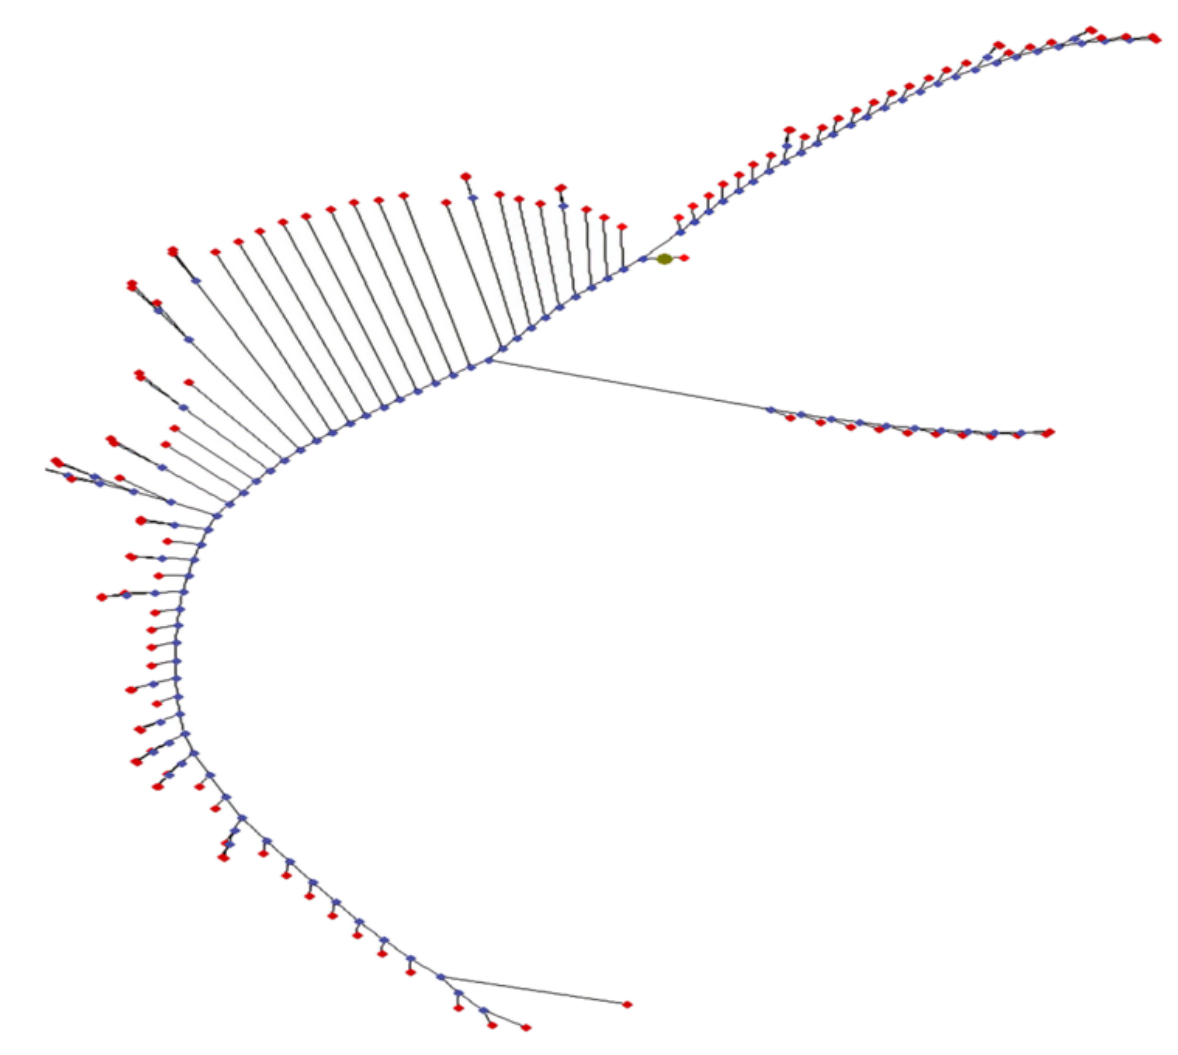
Figure 4. Clustering results of the types of higher edu cation graduates’ employment geography.